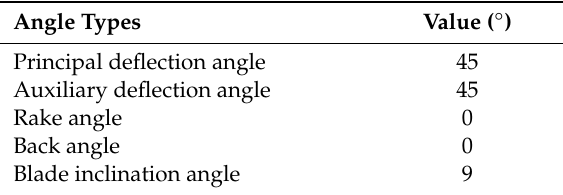
Figure 1. Experimental setup.